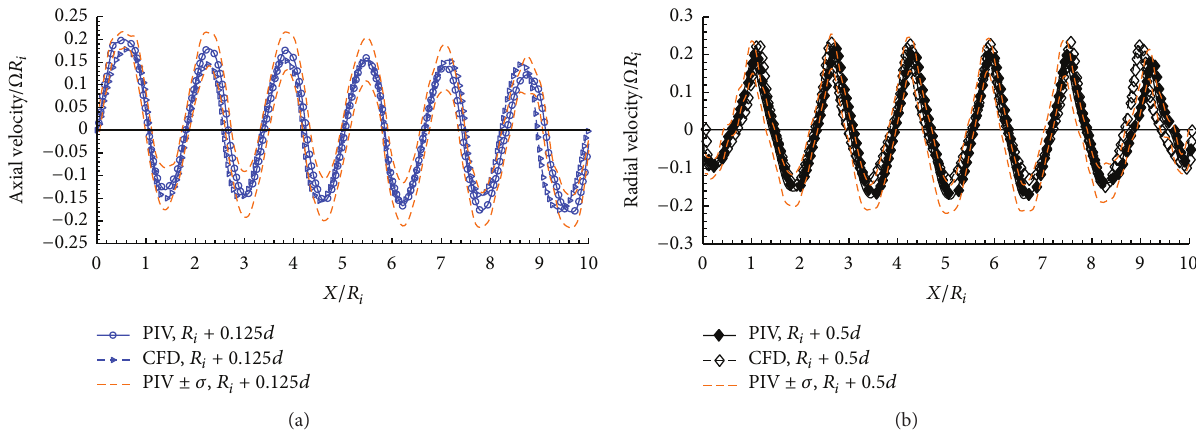
Figure 3: Normalised (a) axial and (b) radial velocity profiles from PIV and CFD at the constant radial positions 𝑟 = 𝑅 𝑖 + 0.125𝑑 and + 0.5𝑑 on the meridional plane 𝜃 = −𝜋/2 , with the PIV error band. Γ = 11.36 . 𝑟 = 𝑅 𝑖